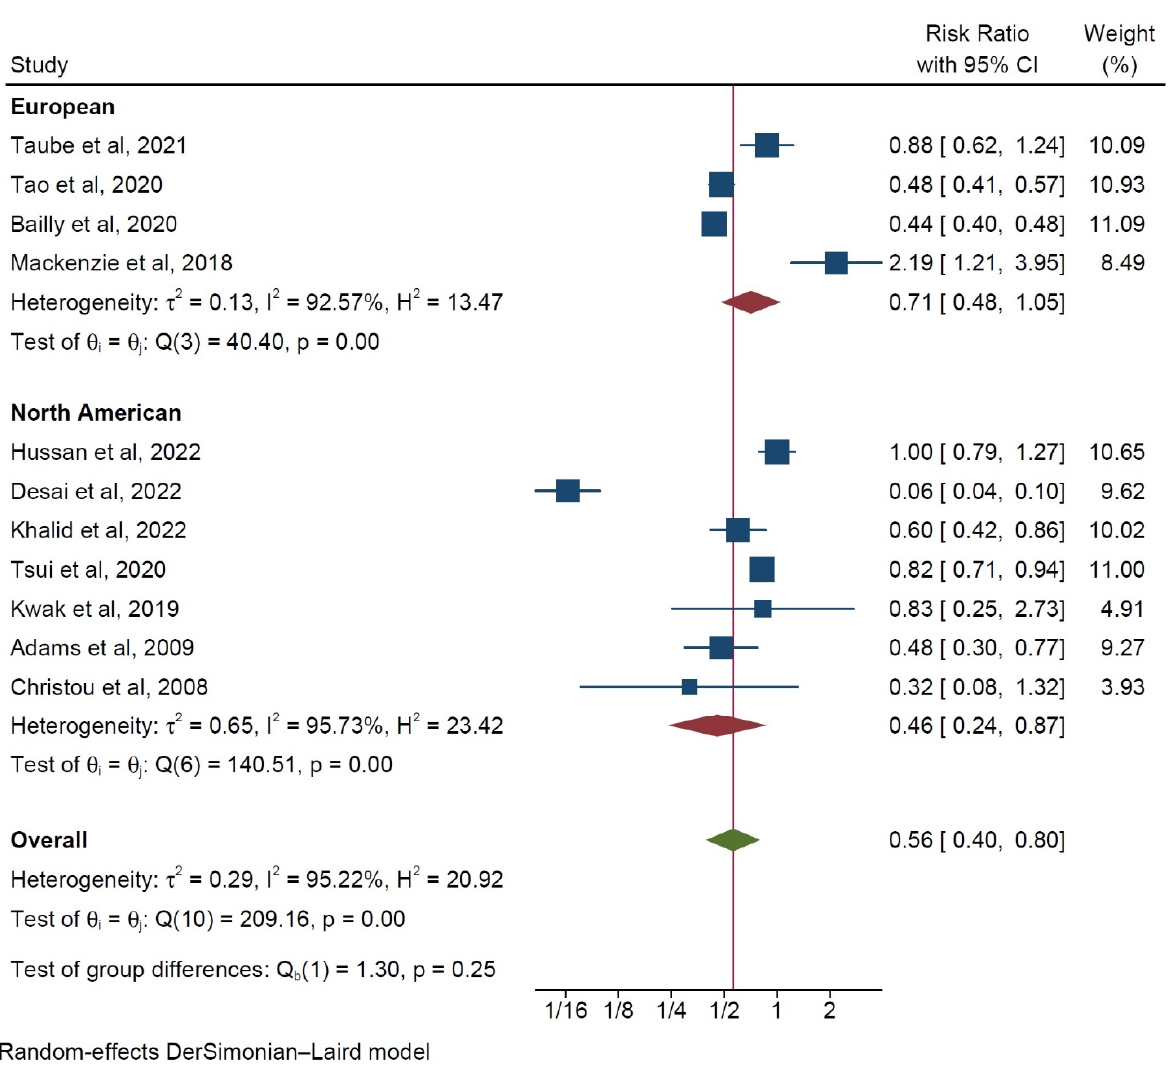
Figure 6. Subgroup analysis of the incidence of colorectal cancer depending on continent of origin [9,10,12–22].